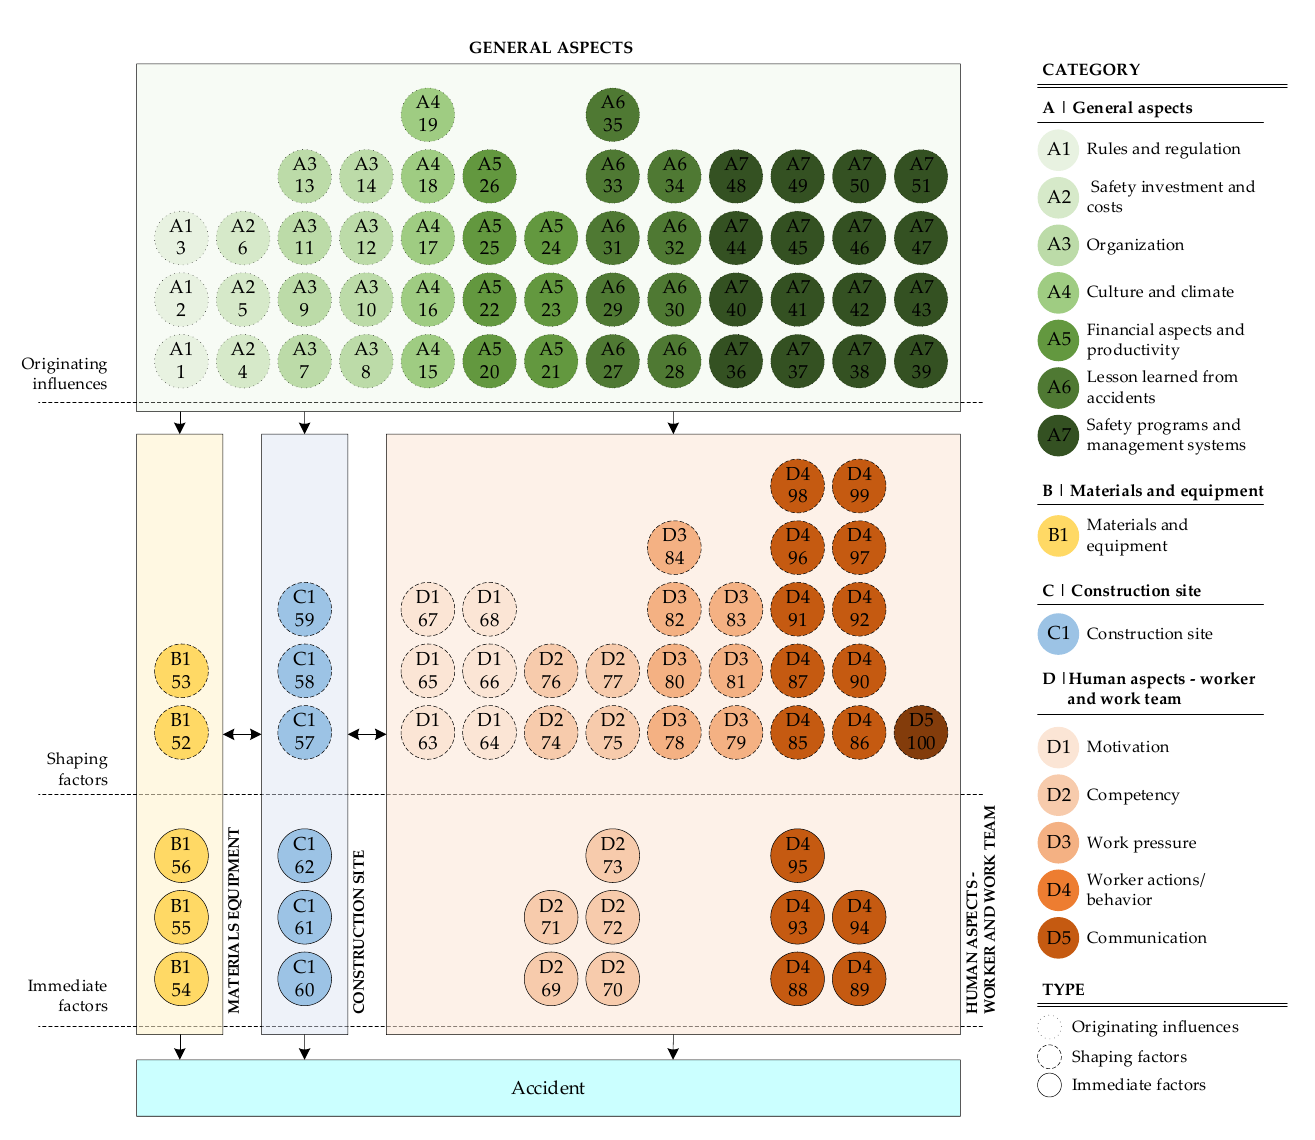
Figure 11. fSCPs mapped to the Construction Accident Causation Framework.